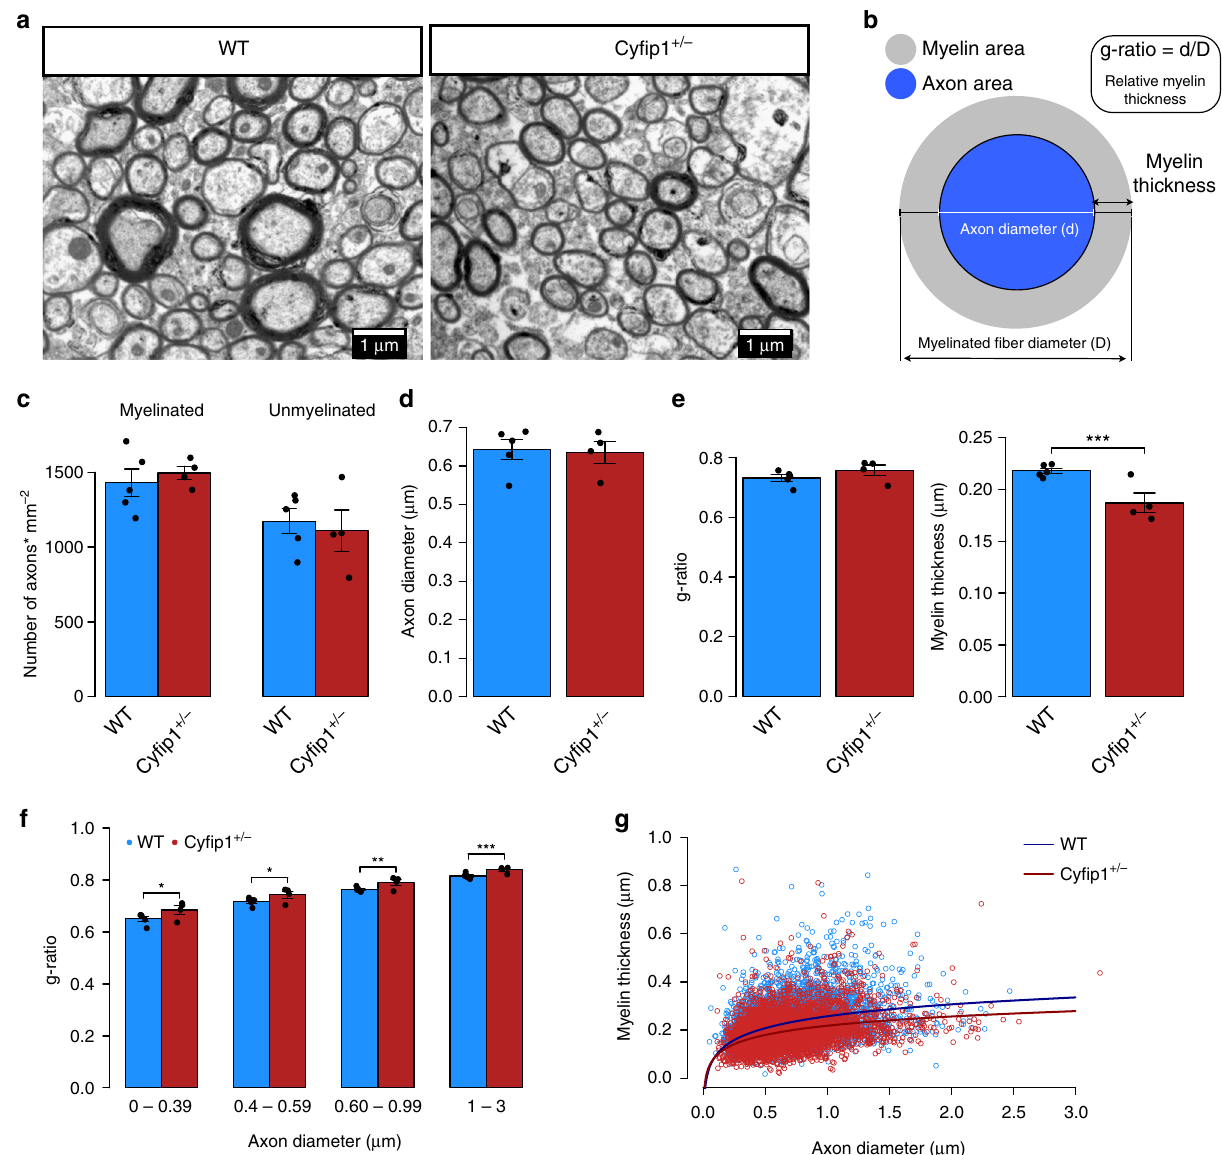
Fig. 2 Decreased myelin thickness in the corpus callosum in the Cy fi p1 + / − rats. a Representative electron micrographs of axons in the WT (n = 5 animals and n = 7148 axons) and Cy fi p1 + / − ( n = 4 animals and n = 5979 axons) rats. b Schematic illustration of the axon and myelin sheath and calculation of the g-ratio and myelin thickness. c Mean number of myelinated ( t = − 0.63, df = 5.72, p = 0.55, ns) and unmyelinated axons per group ( t = 0.39, df = 5.15, p = 0.71, ns), assessed with a two-tailed unpaired t -test. d Mean axon diameter of myelinated fi bres per group (LME: χ 2 (1) = 0.05, p = 0.83). e Mean g-ratio per group (LME: χ 2 (1) = 2.03, p = 0.15) and mean myelin thickness per group (LME: χ 2 (1) = 14.63,***), showing signi fi cant decreased myelin thickness in Cy fi p1 + / − rats. f mean g-ratios calculated for small ( n = 1510 WT and 1276 Cy fi p1 + / − axons; LME: χ 2 (1) = 4.23,*), medium-small ( n =